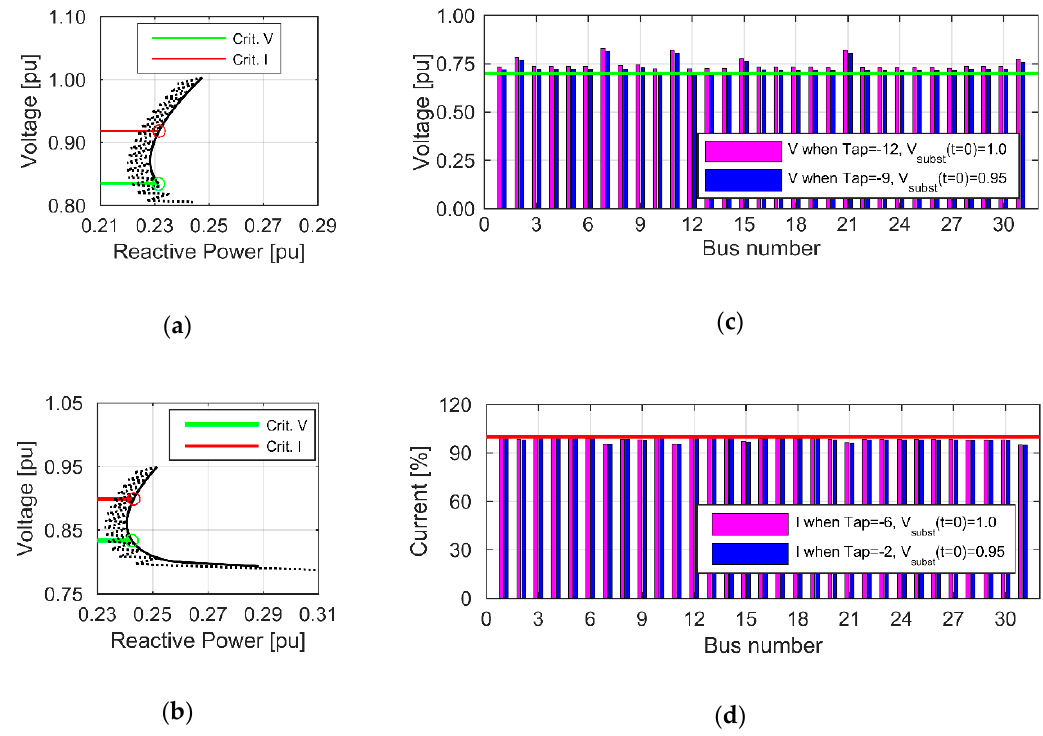
Figure 10. Selected results for the case of voltage change in the HV / MV substation caused by the change of the transformer ratio (“Tap” corresponds to the tap number): ( a ) characteristic V = f ( Q )—case V MV(t = 0) = 1; ( b ) characteristic V = f( Q )—case V MV(t = 0) = 0.95; ( c ) nodes voltage on distribution grid; ( d ) values of the load currents of induction machines.